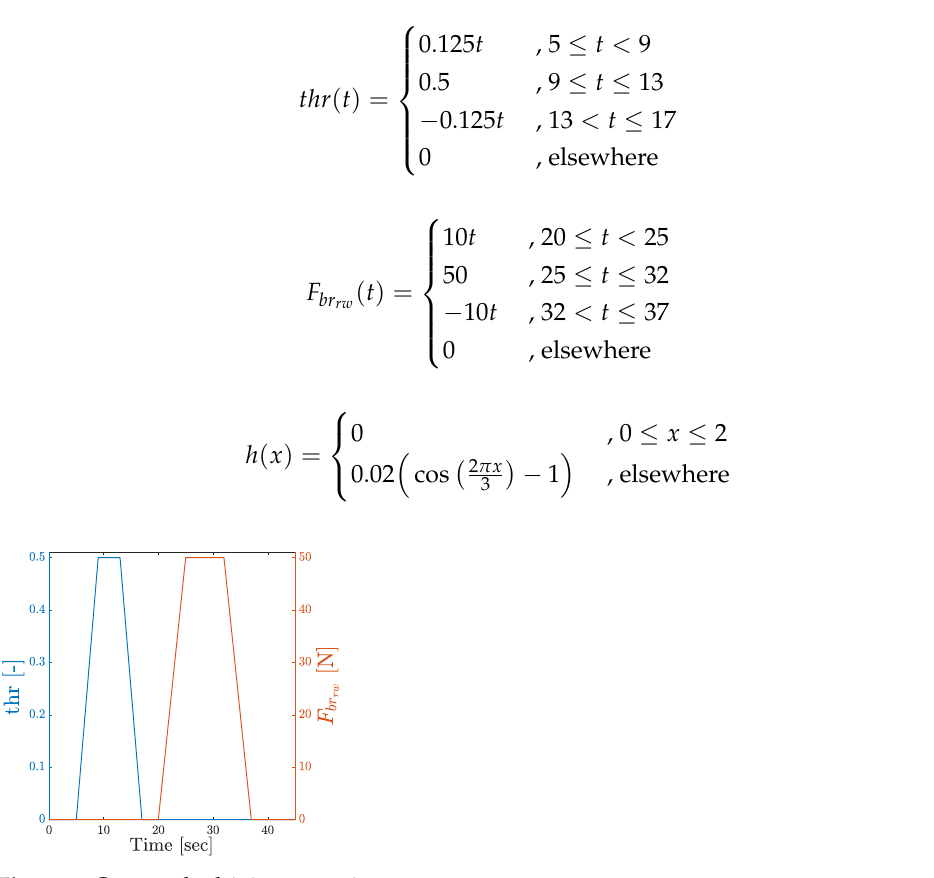
Figure 3. Case study driving